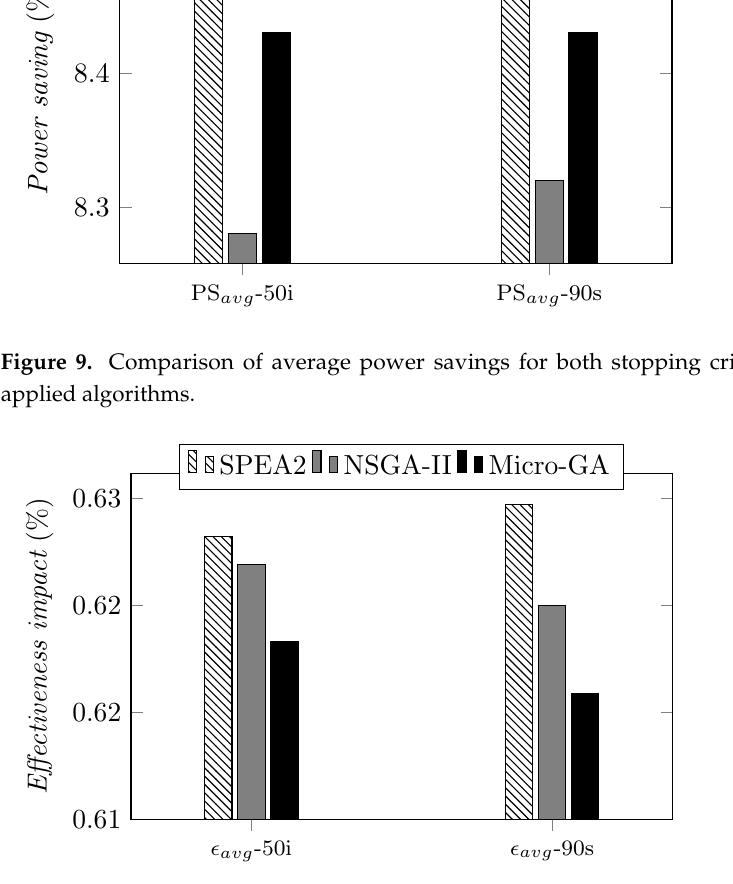
Figure 10. Comparison of average effectiveness improvements for both stopping criteria as obtained by the applied